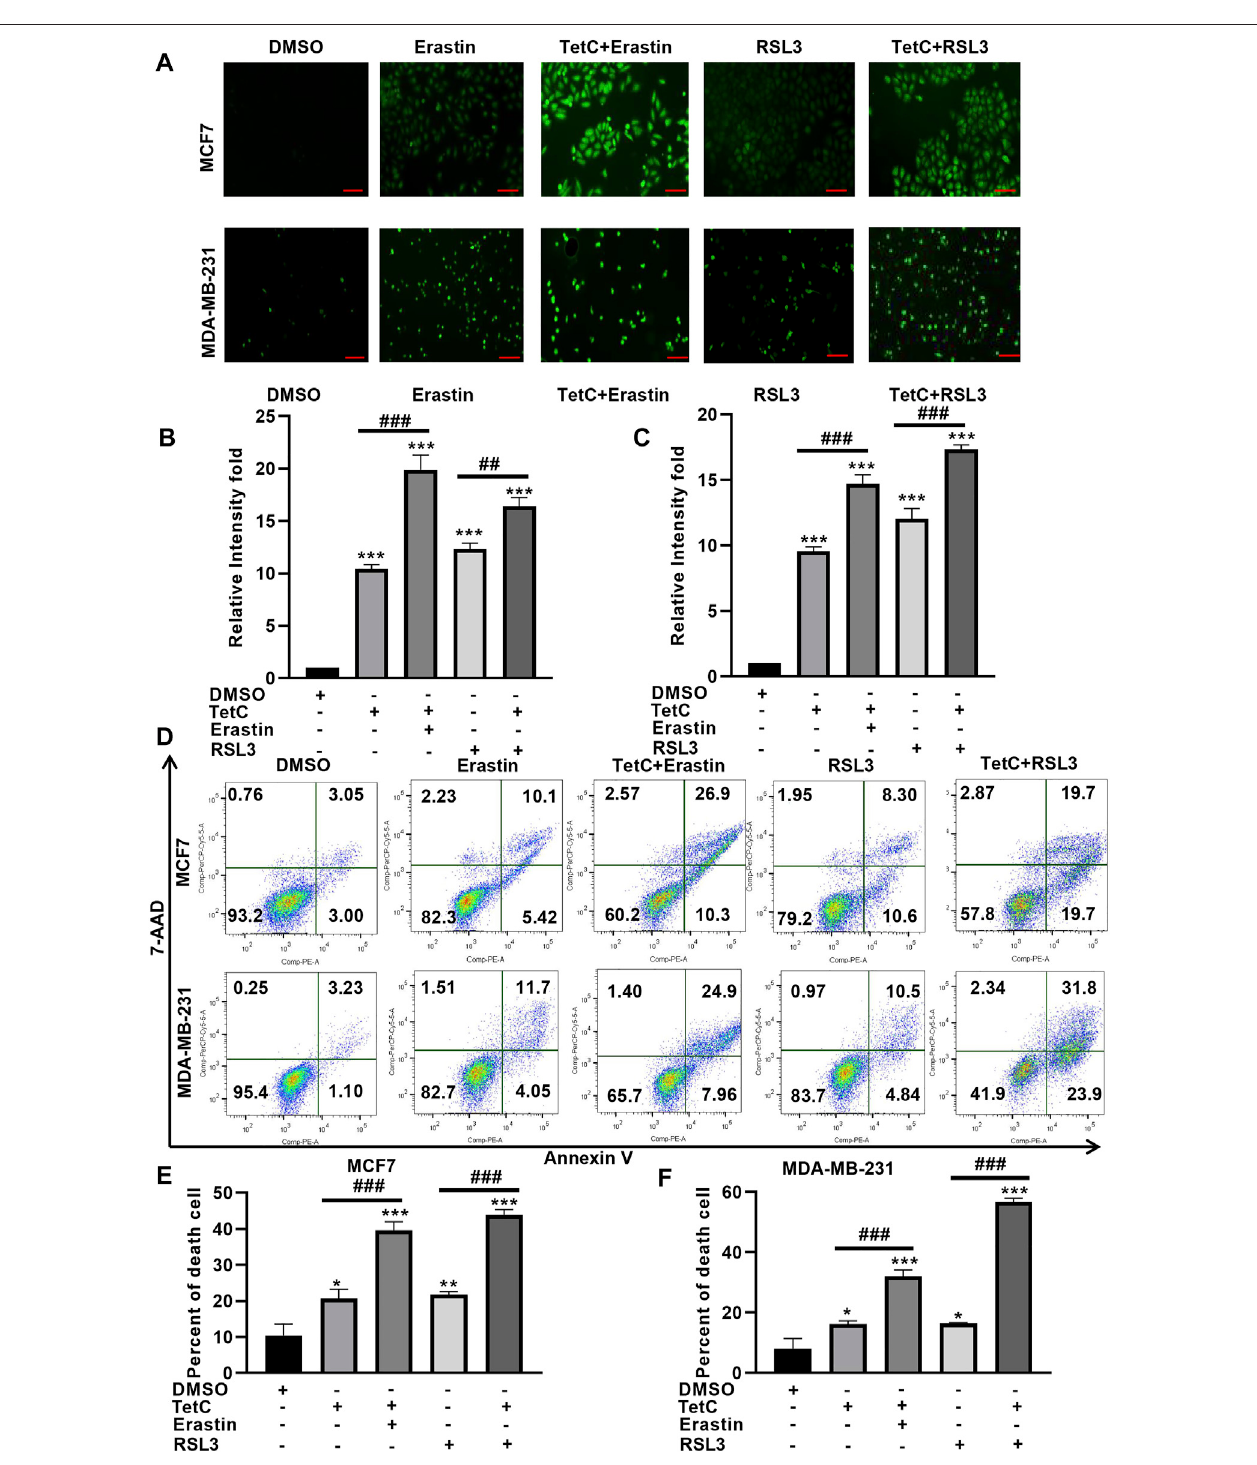
FIGURE 4 | TetC enhances erastin- and RSL3-induced ferroptosis in BC cells. (A – C) DCFH-DA staining showed that a combination of TetC and erastin or RSL3 enhanced ROS generation in MCF7 and MDA-MB-231 cells, compared with those of erastin or RSL3 alone; scale bar, 100 µm. (D – F) Annexin V/7-AAD assay showed thaterastin-andRSL3-inducedferroptoticdamagecouldbefurtherenhancedaftercombinationwithTetCinBCcells( n =3independentrepeats).* p < 0.05;** p < 0.01; *** p < 0.001 vs DMSO; ## p < 0.01; ### p < 0.001 vs erastin or RSL3 alone.